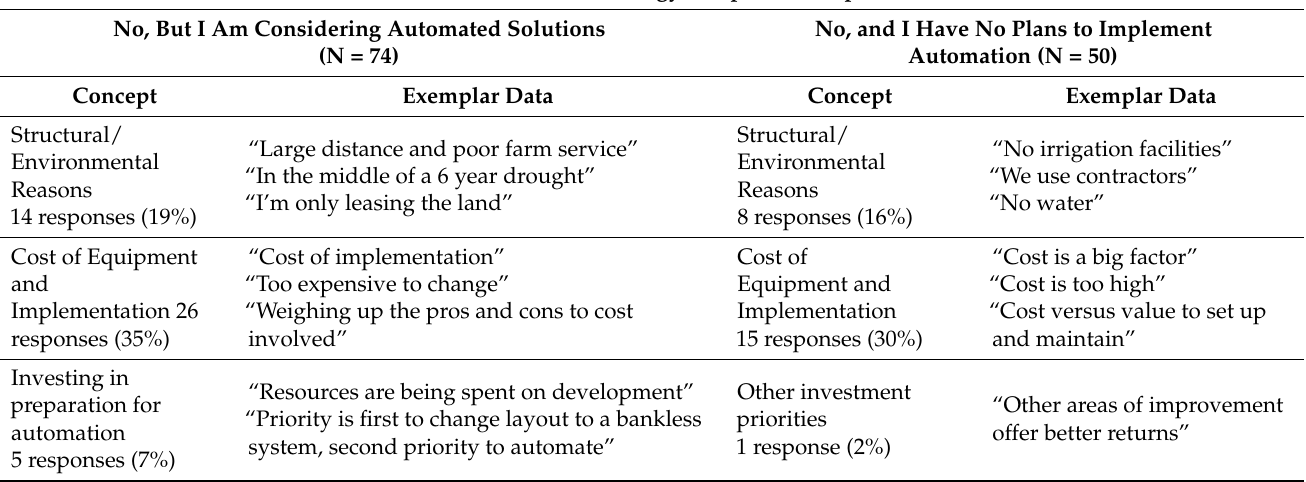
Table 2. Comparison on barriers to adoption between growers considering automated technology and those with no plans to